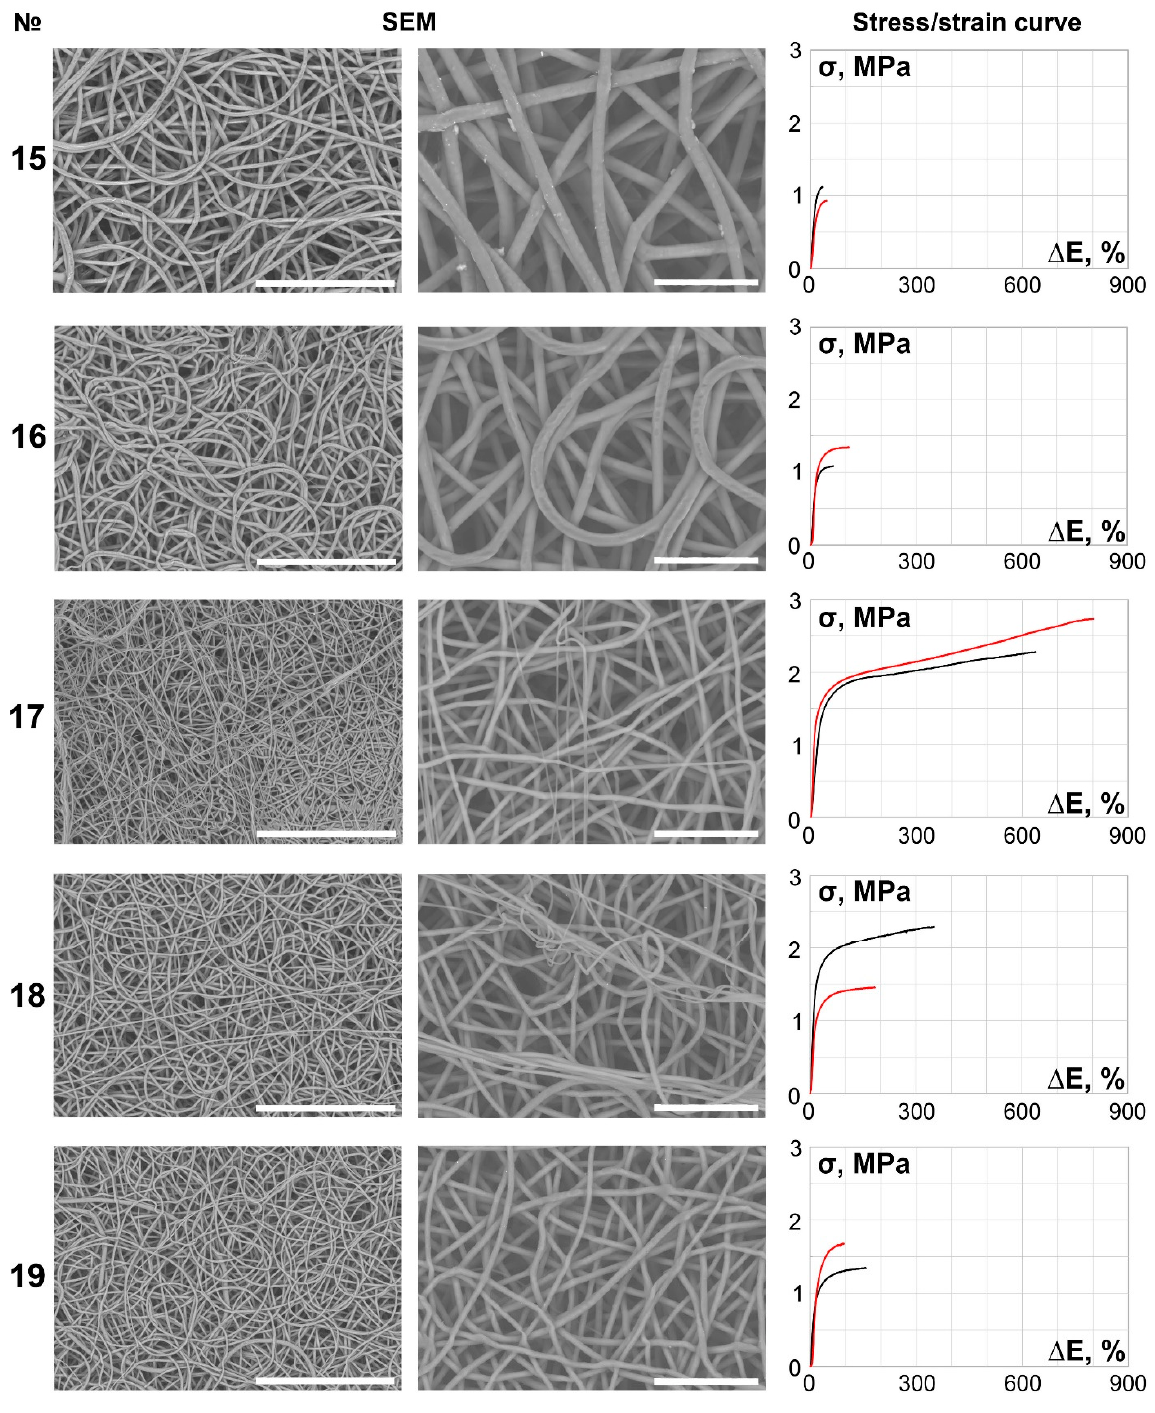
Figure 4. SEM images (×250 magnification, scale bar 200 µm and ×700 magnification, scale bar 50 µm) and stress/strain curves of tested 12% PCL samples. Red curves reflect stress/strain plotting in the axial direction; black curves correspond to circumferential stretching.